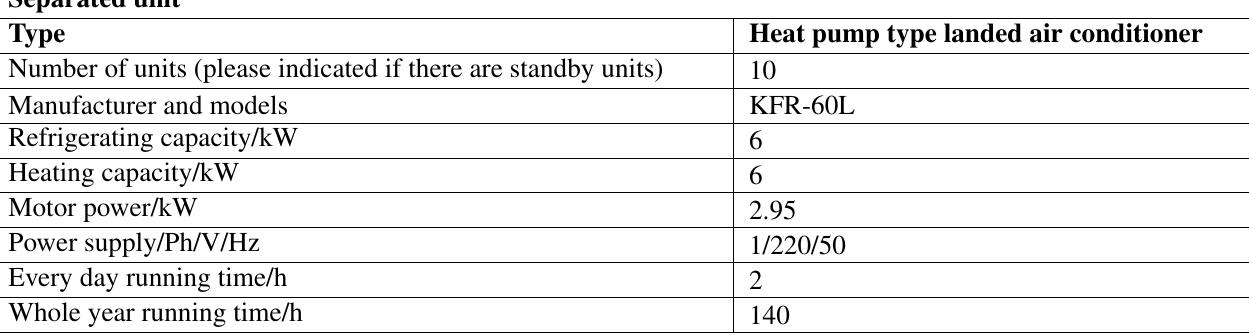
Table 1 Parameters of a separate unit or VRV